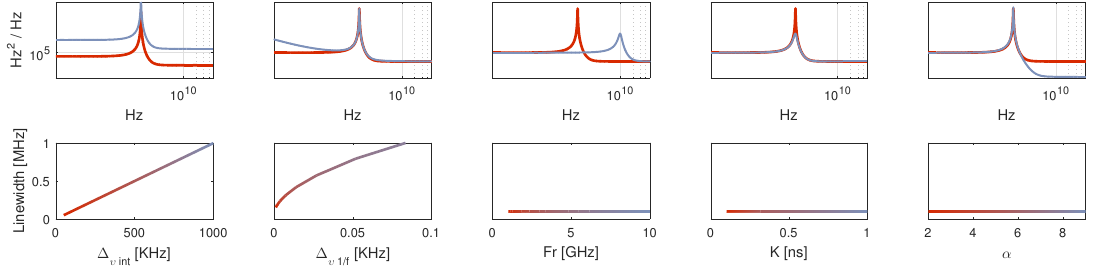
Figure 2. Impact of model parameters on 3 dB linewidth for each parameter of the model (Equation (1)). The upper plots show the spectral shape of the requency modulation (FM) noise at the start ( red ) and the end ( blue ) of the